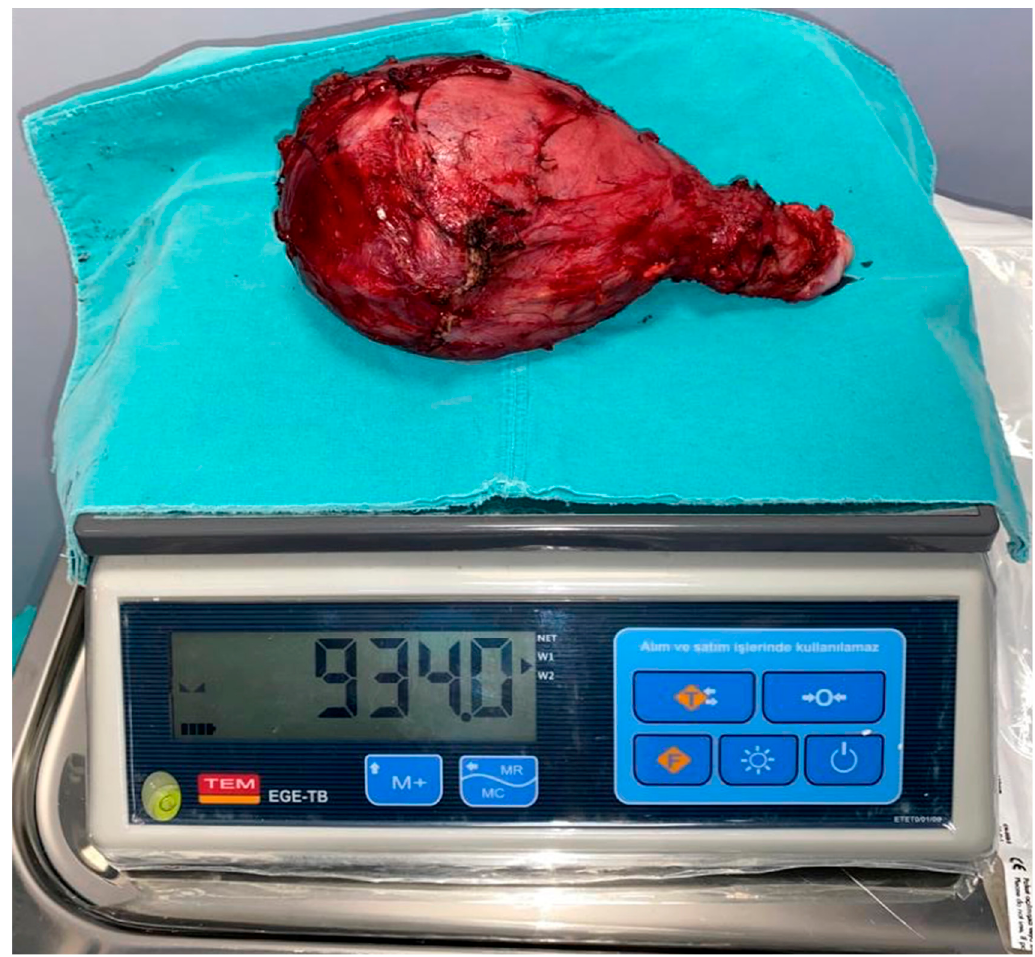
Figure 3. The uterine graft following cesarean hysterectomy.